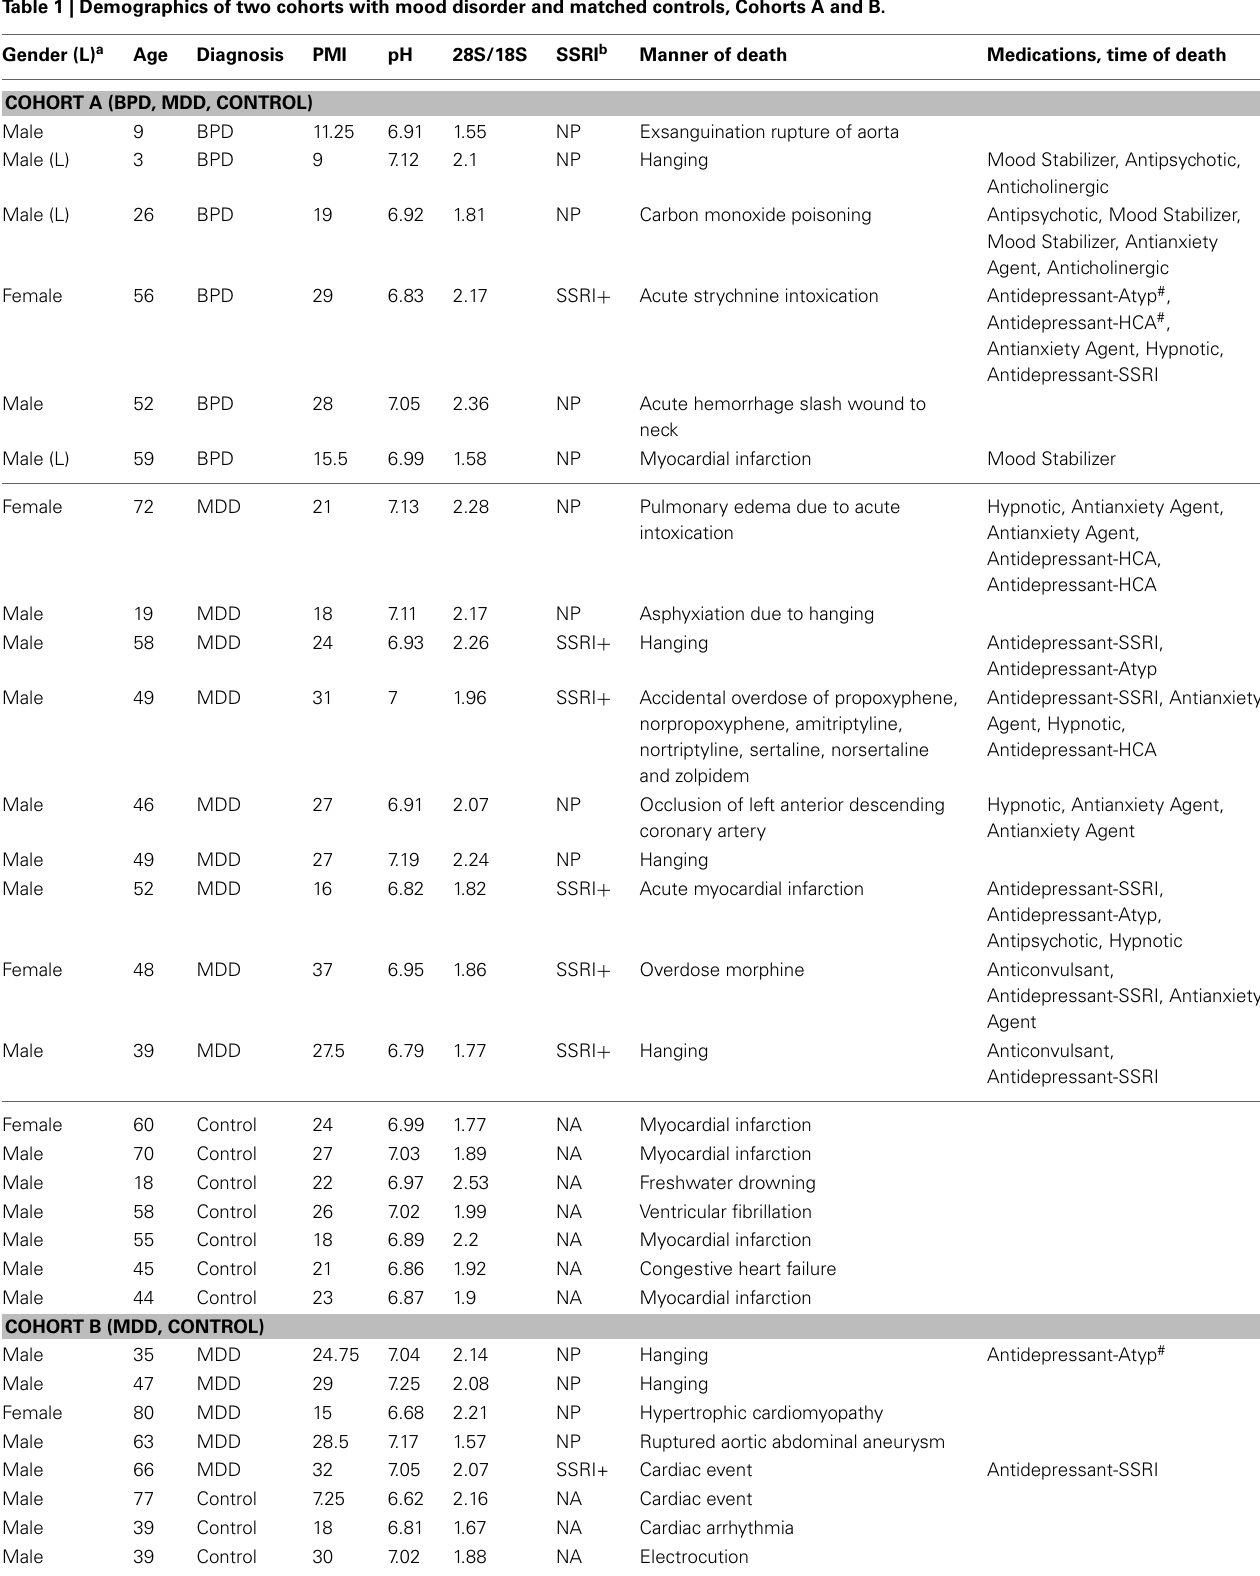
Table 1 | Demographics of two cohorts with mood disorder and matched controls, Cohorts A and B. Gender (L)